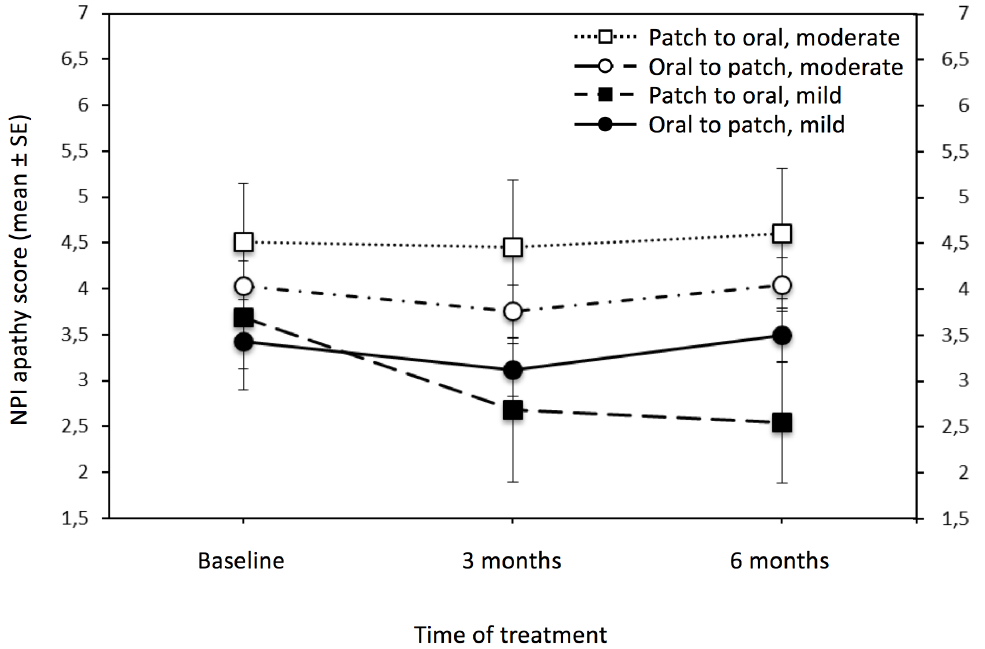
Figure 3. Changes of NPI apathy score during ChEI switch. An analysis of variance with repeated measures indicates that the longitudinal course of apathy symptoms (i.e. NPI apathy score changes during a 6-momth period) in mild to moderate AD patients performing for the first time a switch to another ChEI due to lack of response/reduced compliance, do not change over time (see the results section for statistic details). SE=Standard Error; NPI=Neuropsychiatric Inventory.